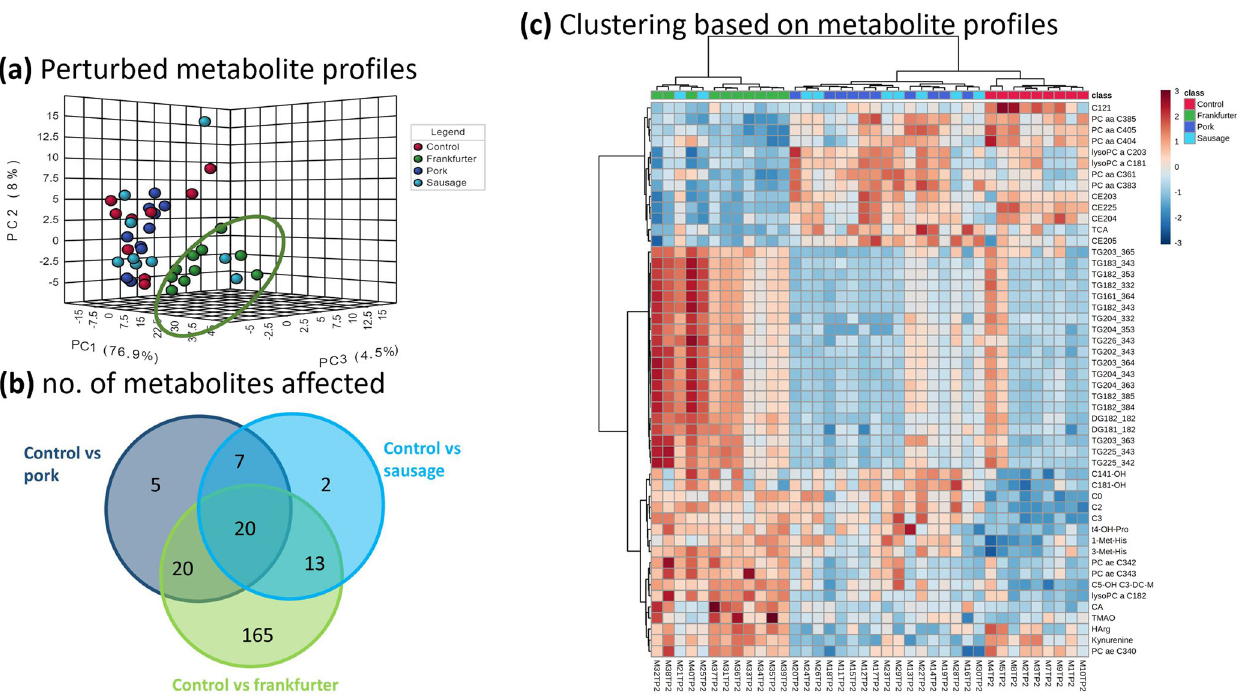
Fig. 2 Serum metabolite pro fi les of frankfurter-fed mice deviate most from control, whereas those fed pork or sausage align more closely. Serum collected at 56 days underwent metabolomic pro fi ling: a shows scores plots of unsupervised PCA based on the fi rst three principle components (PCs) for Control ( n = 9; standard chow (red)), or chow with a 15% incorporation of pork mince ( n = 9; blue), pork sausage ( n = 10; light blue), or nitrite-containing frankfurter sausage ( n = 10; green). Metabolomic data explained 89.4% of the total variation (76.9, 8.0, and 4.5% for PC1, PC2, and PC3, respectively). There was a tendency for pro fi les from the frankfurter group to separate along the PC1 axis. Pro fi les from control, pork, and sausages groups clustered more closely with variation more restricted to PC2. b is a Venn diagram showing the number of the 599 metabolites measured which signi fi cantly differed in group comparisons with control. c heatmap with hierarchical clustering based on the top 50 metabolites ranked by FDR-corrected P -value (ANOVA). Each row represents a metabolite and each column a sample. Red (high) and blue (low) indicates relative concentrations. Dendrograms indicating similarity are shown at top (samples) on left side (metabolites). Serum metabolite measurements readily clustered mice by diet with pork and nitrite-free sausage being most similar to one another. Frankfurter consumption was characterised by signi fi cantly higher levels of certain species of diglycerides (DG), triglycerides (TG), and acylcarnitines (C), and by lower levels of certain phosphatidylcholines (PC/LysoPC) and cholesterol esters (CE). Other notable observations included the differing bile acid responses of taurocholic acid (TCA) and cholic acid (CA). The profound variability of trimethylamine N-oxide (TMAO) responses in frankfurters was also very evident. Control samples are shown in red, minced pork in dark blue, nitrite-free sausage in light blue, and frankfurter (nitrite-containing) in